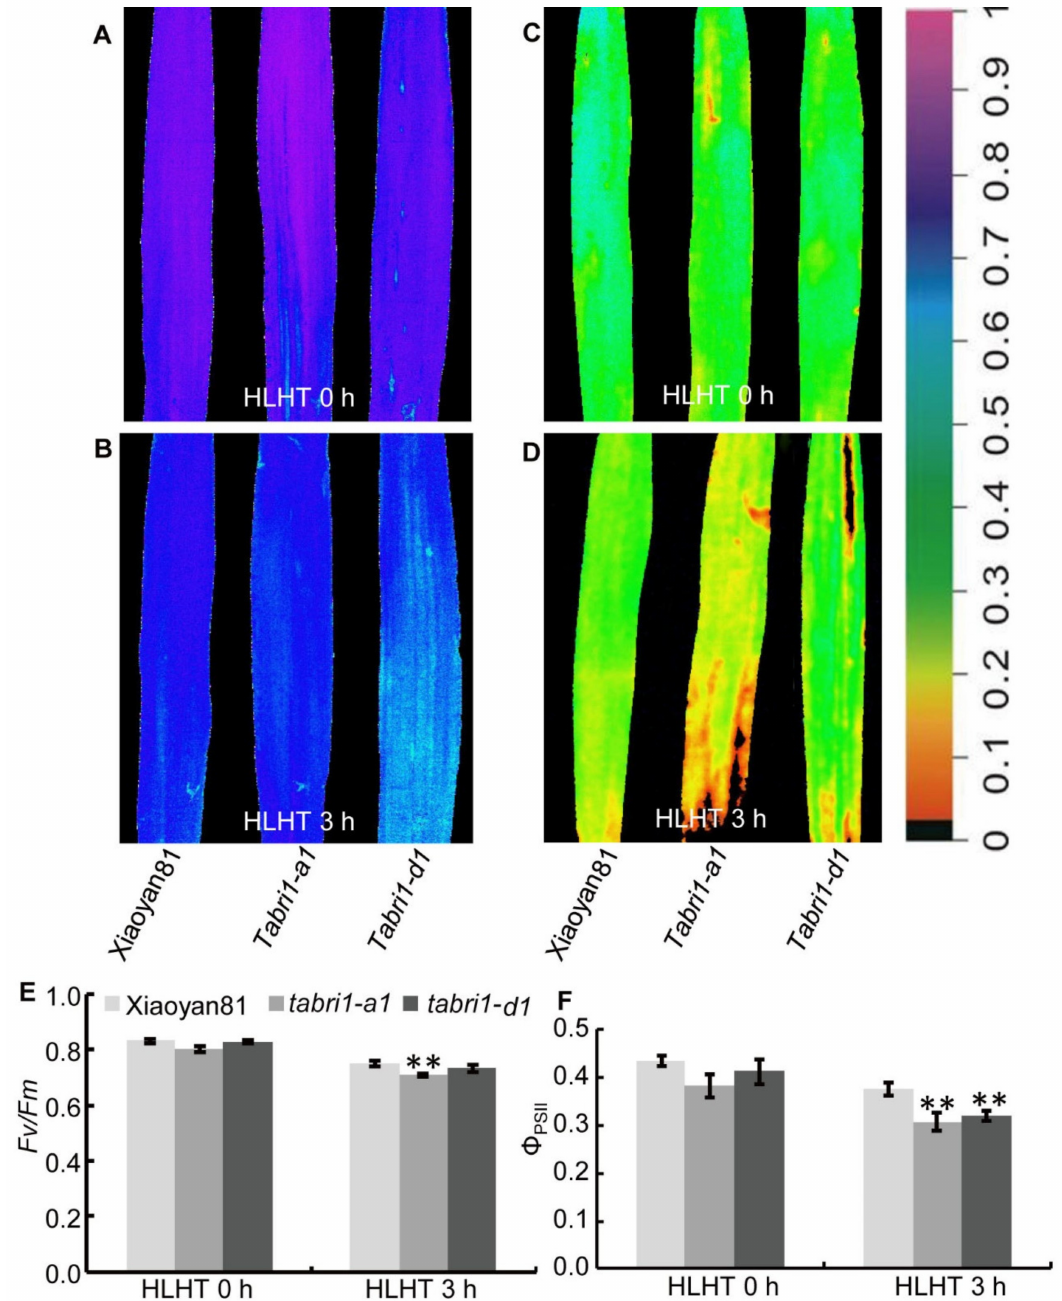
Figure 7. Chlorophyll fluorescence parameters of detached flag leaves in WT and TaBRI1 mutants at 14 DPA under HLHT 3 h. ( A – D ) Images of the maximum photochemical e ffi ciency ( Fv / Fm ) ( A , B ), the actual PSII e ffi ciency ( Φ PSII ) ( C , D ) of WT and TaBRI1 mutants under high light and high temperature (HLHT) 3 h. The color in ( A – D ) represents the value of each parameter in the color scale. ( E , F ) Statistic analysis of Fv / Fm , Φ PSII in ( A – D ), respectively. Data from three biologic replicates, and each biologic replicate comprised eight plants. ** indicates significant di ff erences between WT and TaBRI1 mutants at p <